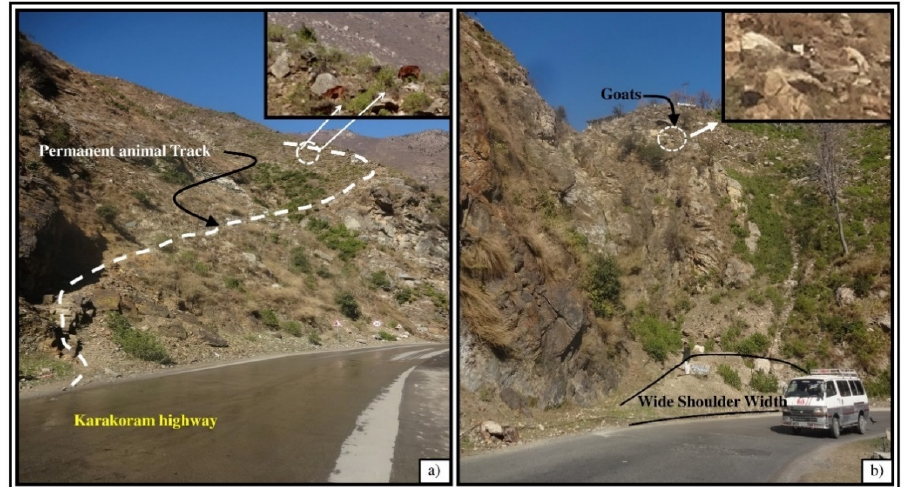
Figure 2. ( a ) Animals always follow a permanent track to reach the grazing altitude. Cows push larger stones compared to goats. ( b ) Goats grazing at a random track push stones that might not reach the road due to wider shoulder width.